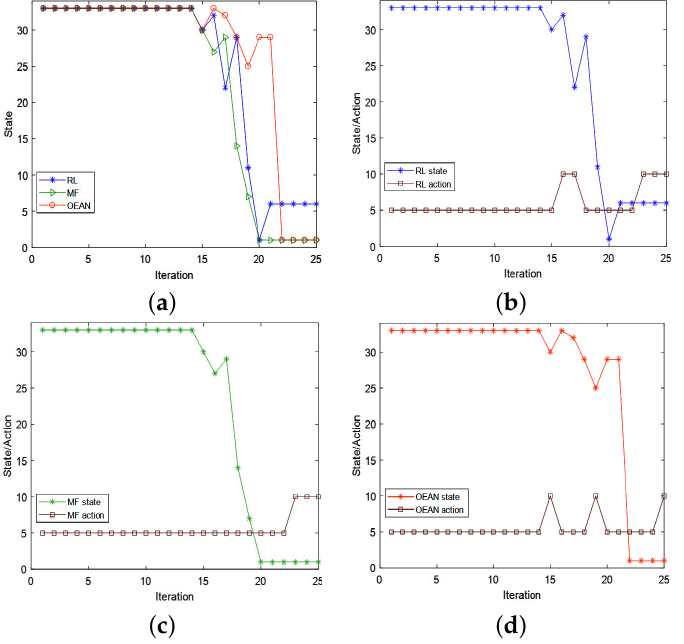
Figure 6. Tests result with the random location of the rock particles in the coal layer. ( a ) is the states of three methods. ( b ) is the states and actions of RL. ( c ) is the states and actions of MF. ( d ) is the states and actions of